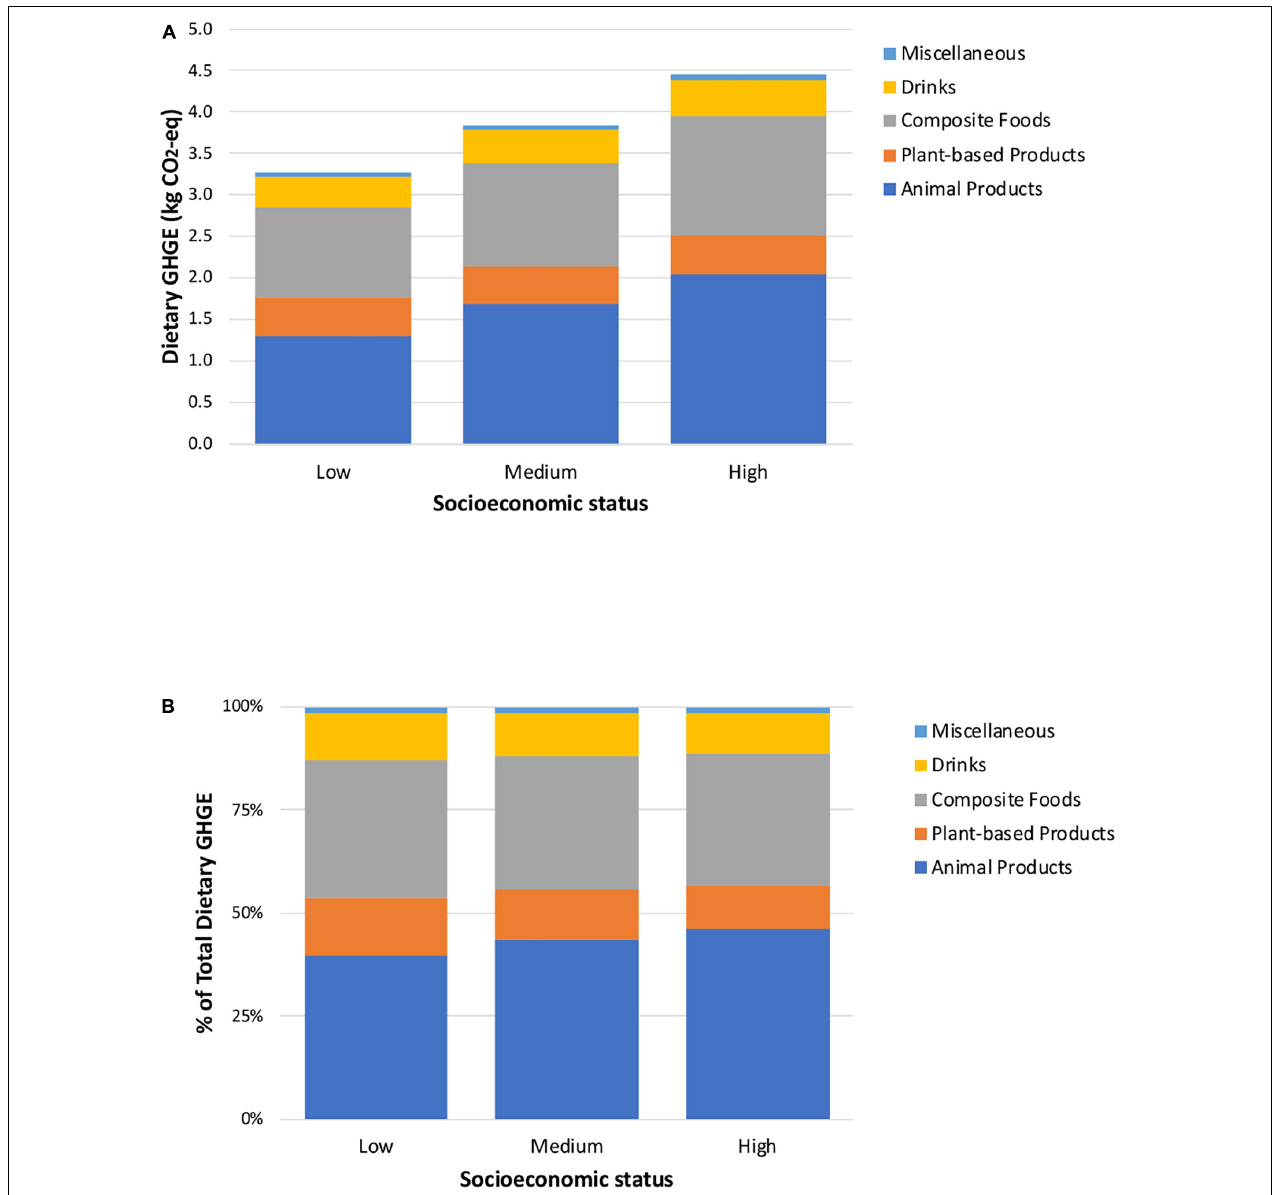
FIGURE 1 | Absolute (A) and relative (B) contribution of each aggregated food and beverage group to total dietary greenhouse gas emissions, stratified by socioeconomic